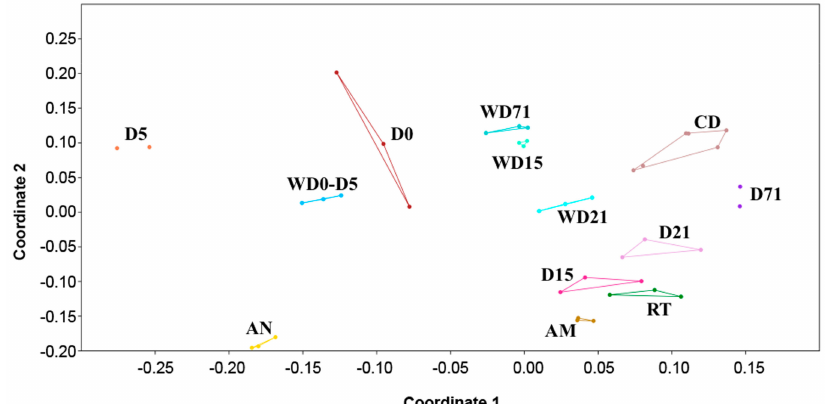
Figure 3. Non-metric multidimensional scaling (nMDS) plot displays of the bacterial communities of all sample categories (larvae, rearing water and feeds) based on Bray–Curtis distances. D: Day, AM: Artemia salina metanauplii, AN: Artemia salina nauplii, CD: Commercial diet, RT: Rotifers, W: Water sample.